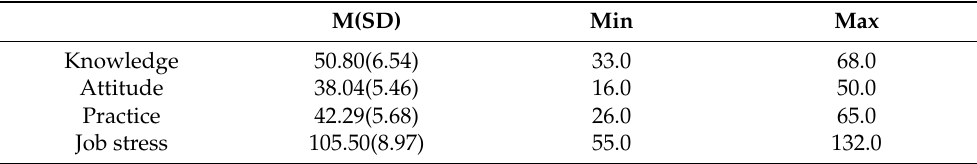
Table 2. Degree of job stress, knowledge, attitudes, and practices of the subjects.